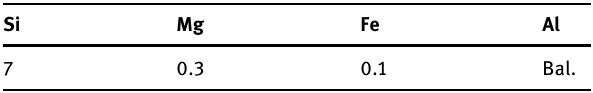
Table 1: Chemical composition of original Al – Si powder ( wt%